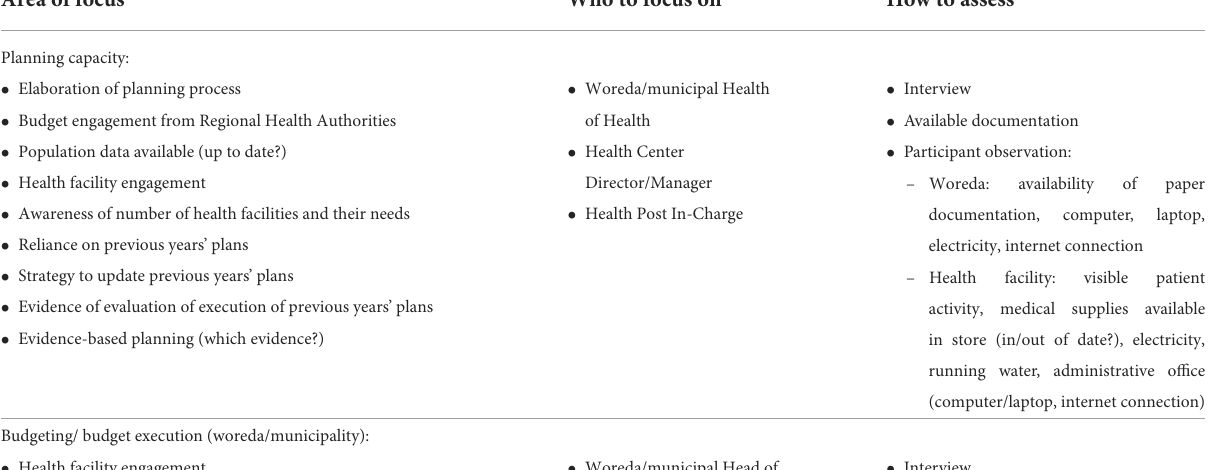
TABLE 1 Framework of assessment and analysis to establish healthcare delivery bottlenecks at woreda/municipal level in Ethiopia’s Somali Region. Area of focus Who to focus on How to